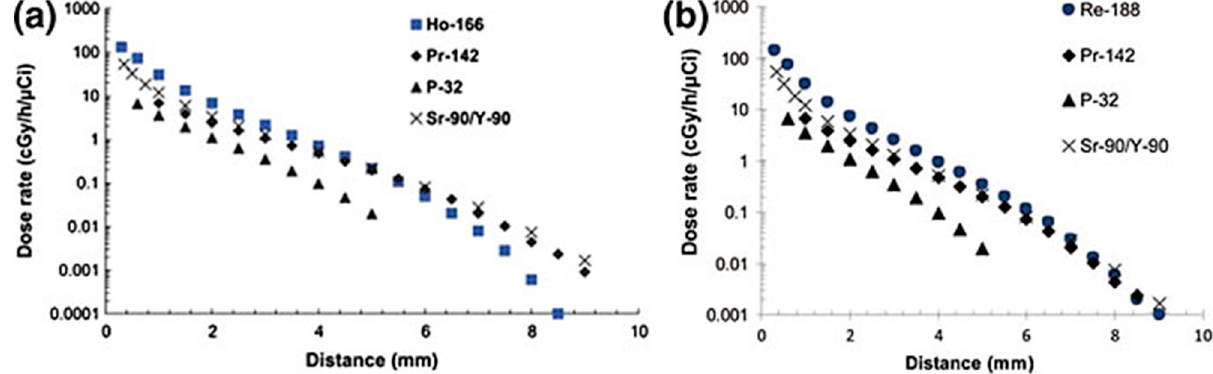
Figure 9. Comparison of the dose rate vs. distance for different glasses containing beta emitters. Figure adapted from Hosseini et al. [76] ( a ) and Khorshidi et al. [77] ( b ).